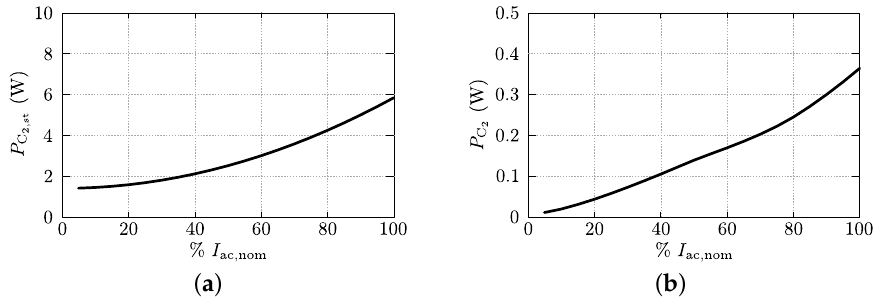
Figure B4. ( a ) Calculated total losses of the LF output filter capacitors C 2,st ; ( b ) Calculated total losses of the HF output filter capacitors C 2 .